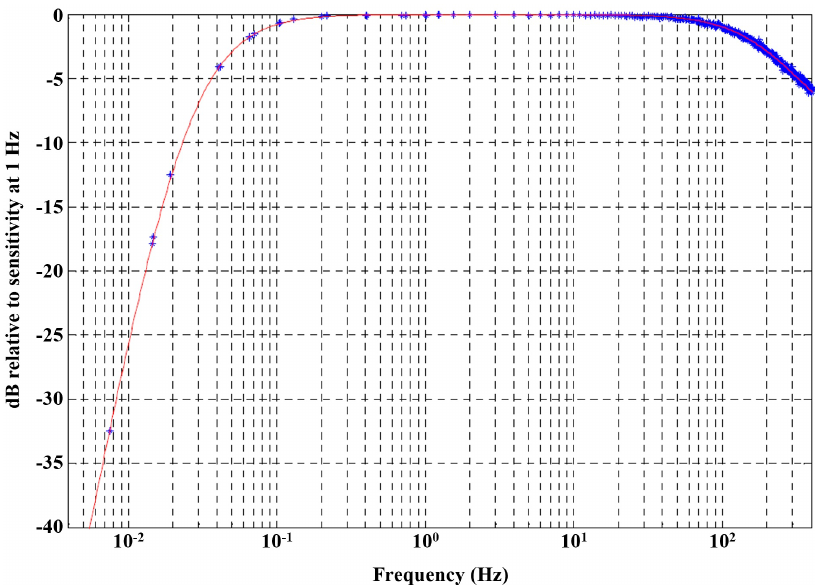
Figure 1. Typical frequency response curve for a model 24 (Chaparral Physics) microphone, which was used for this deployment of GLINDA. Credit: Chaparral